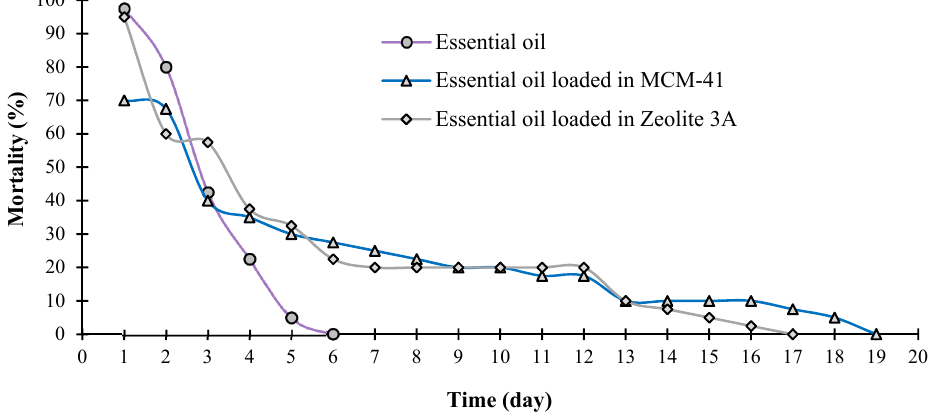
Figure 5. Fumigant toxicity and persistence of pure and nanoencapsulated Eucalyptus largiflorens essential oil against Callosobruchus maculatus . A concentration of 6.25 μ L/L air (24-h LC 90 value) was considered for both pure and nanoencapsulated oil. To eliminate the mortality in the control group (without any essential oil), the mortality percentage observed each day was corrected using Abbott’s formula.